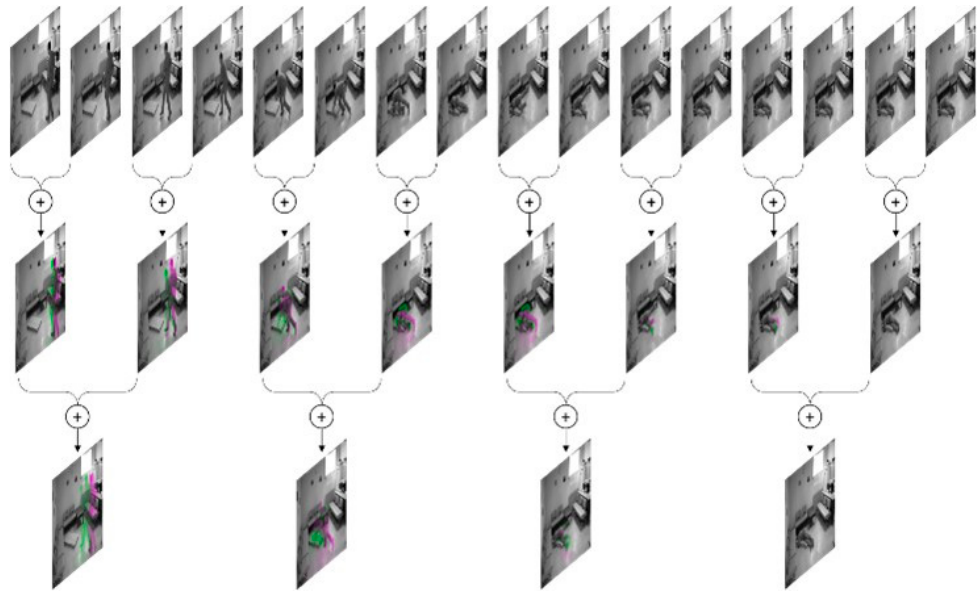
Figure 4. Two-level image fusion to produce 4 fused images out of the 16 input